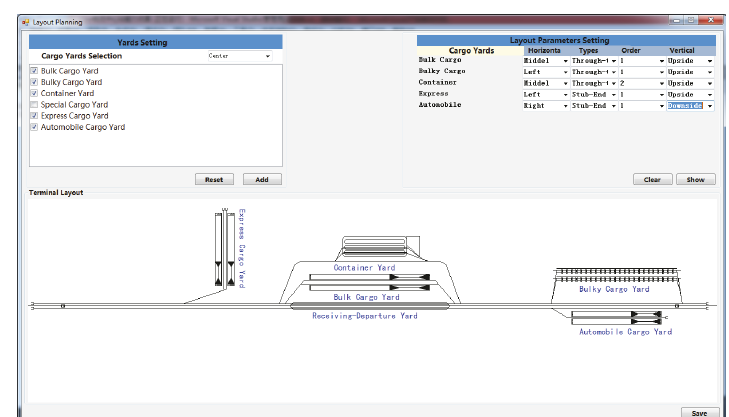
Figure 8: Interface of terminal layout planning.